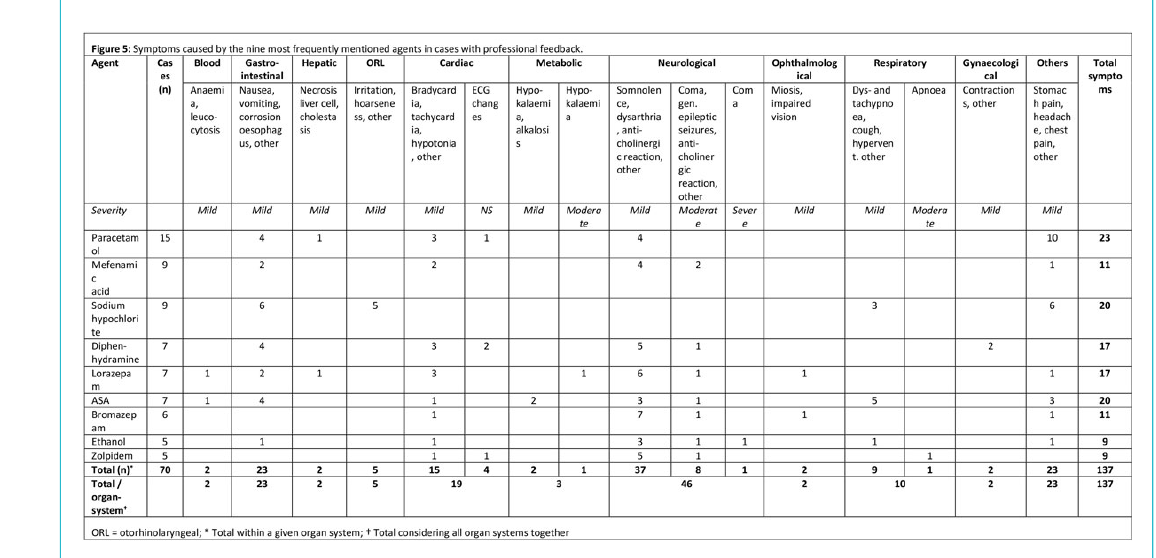
Figure 5: Symptoms caused by the nine most frequently mentioned agents in cases with professional